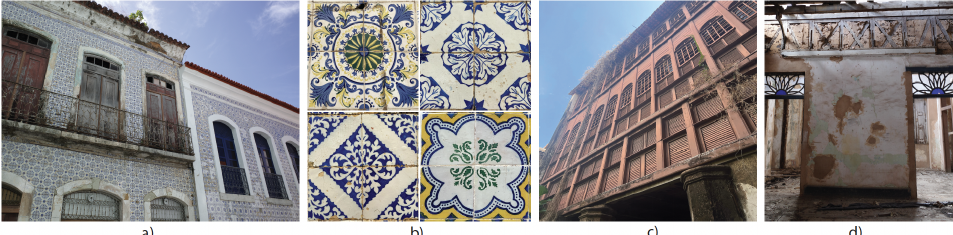
Figure 1. Characteristics of the architectural typology in the historic center of São Luís: ( a ) facade of buildings at Rua Portugal, one of the most famous streets in the historic center; ( b ) different patterns of the facade tiles; ( c ) internal patios; ( d ) wall evidencing the Santo André cross